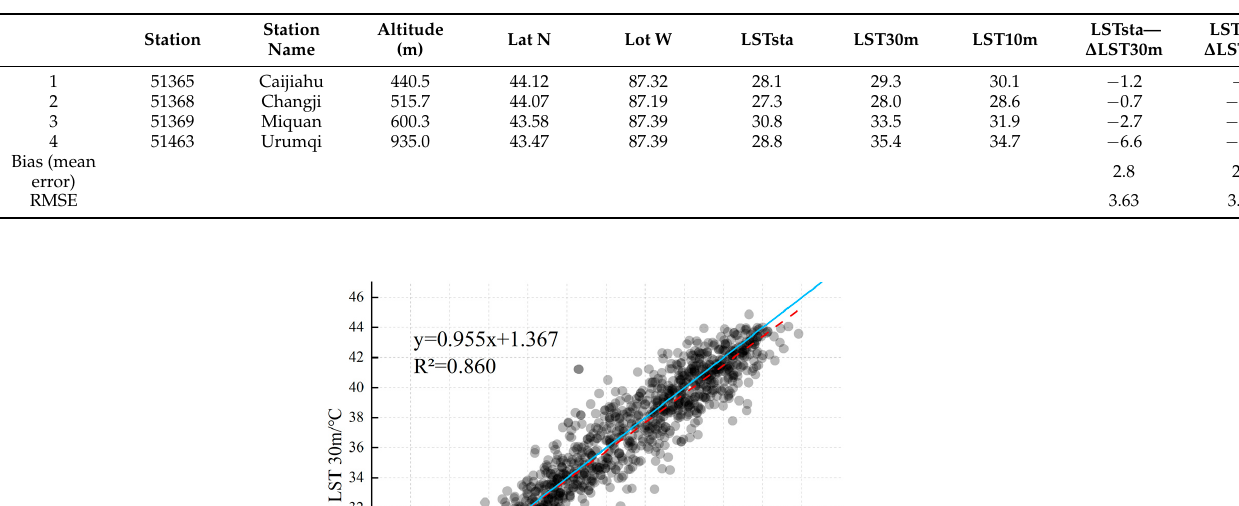
Table 5. Comparison of weather station LST with the LST at the same location.